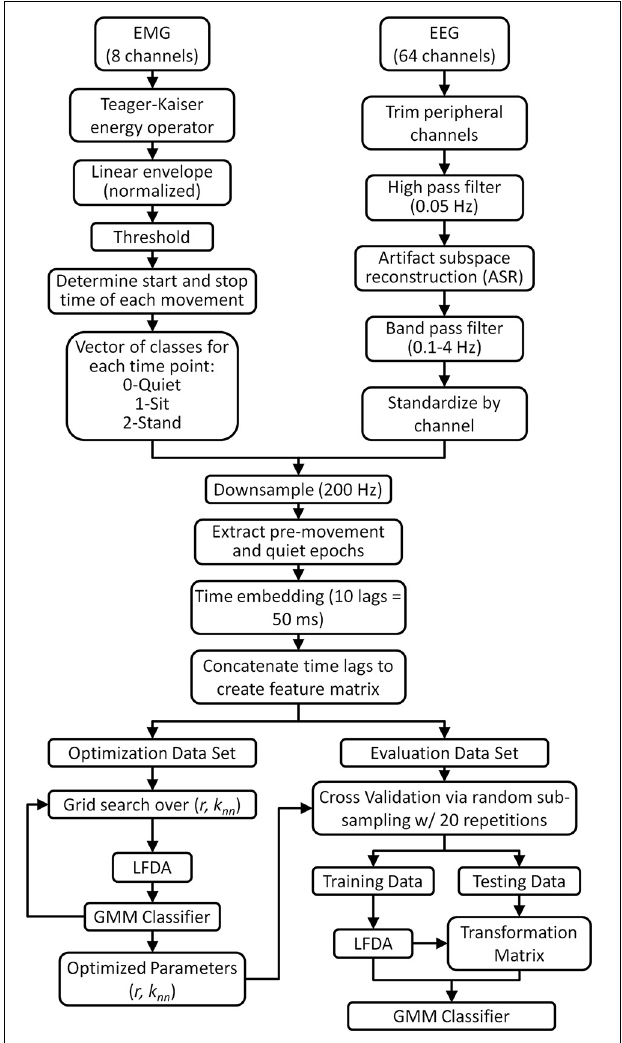
FIGURE 1 | Flow chart describing the EMG and EEG data processing for neural decoding of sitting and standing movement. A threshold of 3 standard deviations was applied to the EMG linear envelope to identify quiet periods and periods of movement (sitting and standing). Only pre-movement epochs (1.5s before movement to movement onset) and quiet epochs (1.5s after movement completion to 1.5s before next movement) were retained for analysis. As a control, a separate decoding analysis using movement epochs (movement onset to 1.5s after onset) was also performed. Artifact subspace reconstruction (ASR) algorithm, available as a plug-in for EEGLAB software (Delorme and Makeig, 2004), was applied to eliminate artifacts from EEG data during pre-processing. Note that the optimization and evaluation data sets are mutually